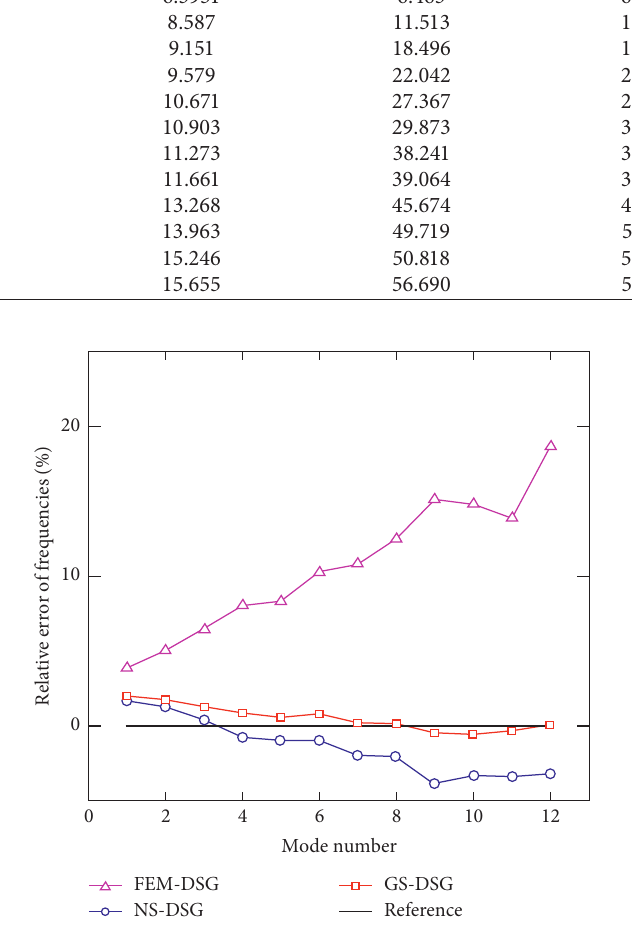
Figure 13: Relative errors for the first 12 parameterized natural frequencies of the elliptical plate.